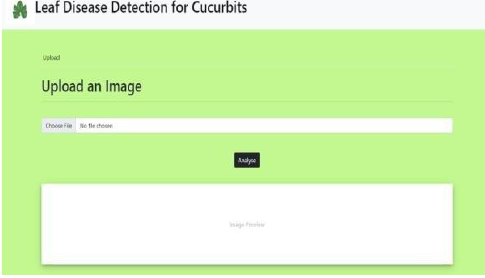
Fig12. Displaying the result after analysis (Healthy)